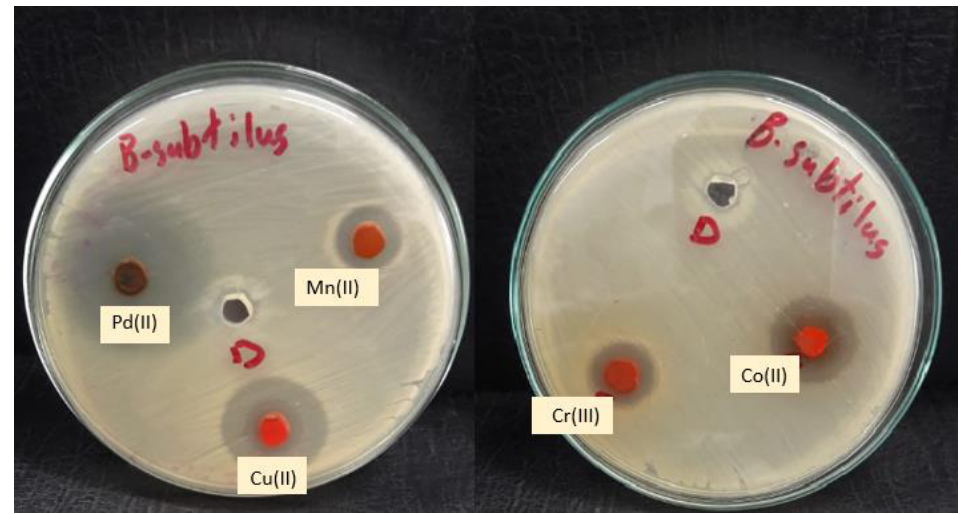
Figure 15. Microbiological screening of coordination compounds of Mn(II), Co(II), Cu(II), Cr(III), and Pd(II) toward Bacillus Subtilis .